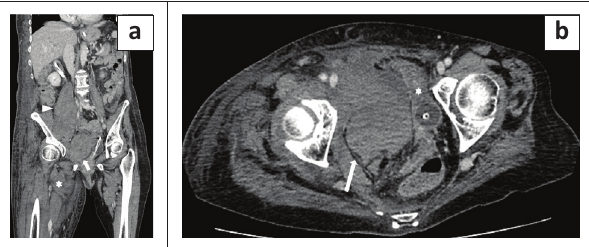
FIGURE 2: A 74-year-old woman with multiple haematomas, the first diagnosed 28 days after hospital admission. (a) Coronal plane, venous phase: the image shows the haematomas in the right iliopsoas muscle (arrowhead), in the right Retius’ space (arrow) and in the vastus medialis muscle of the right thigh (asterisk). (b) Axial plane, venous phase: the image shows the haematoma in the Retius’ space on the right side (arrow), displacing the bladder with urinary catheter inside the lumen (asterisk). The same patient later developed pulmonary thrombo-embolism (not shown).